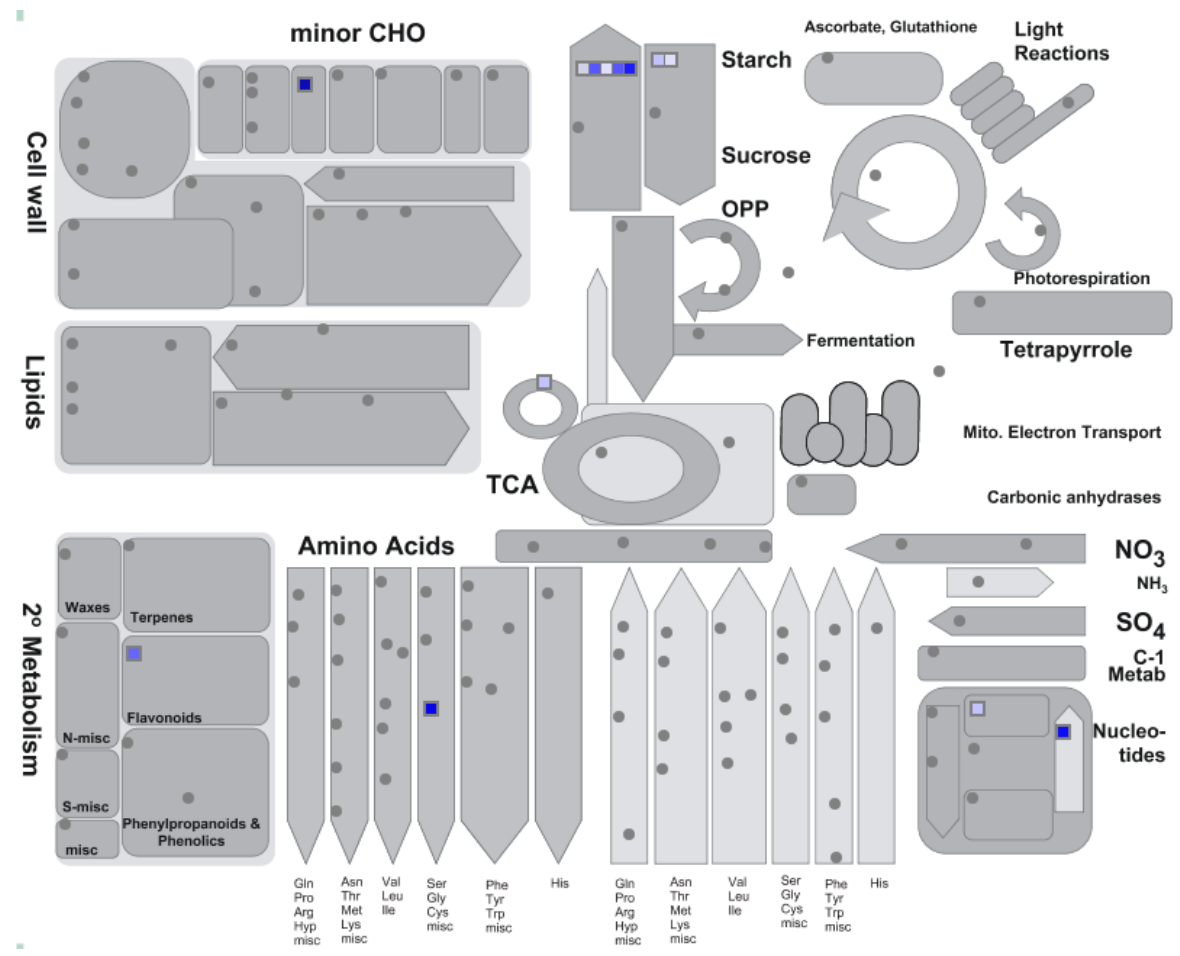
Figure 4. Co-expression analysis of plastidic GS. An overview of general metabolism was created using MapMan. Blue squares represent genes that are positively co-expressed (Pearson distance <0.3) with plastidic GS. The intensity of the blue color is proportional to the degree of correlation between a certain gene and the plastidic GS